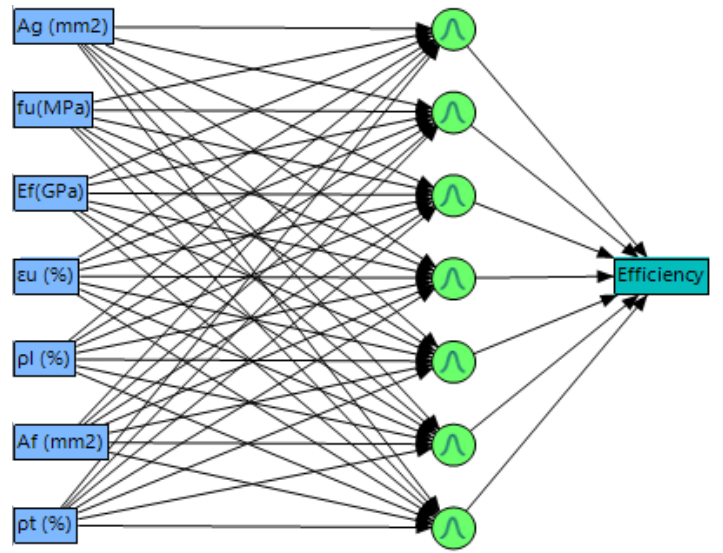
Figure 4. ANNs structure for the dataset .